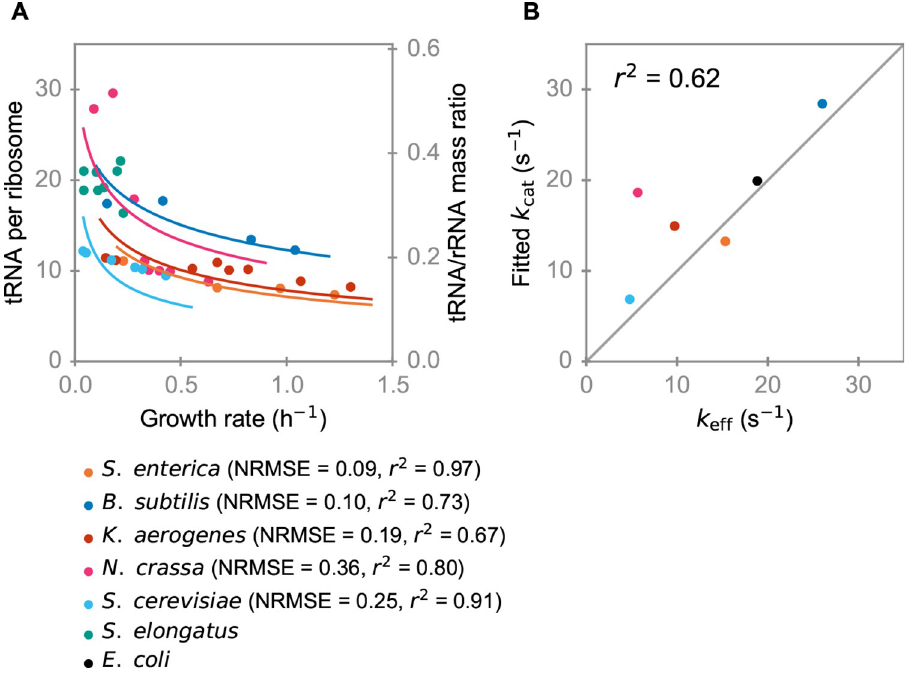
Fig 2. The RNA growth law across species. (A) Experimentally observed tRNA/ribosome expression ratios in different microbes decrease with growth rate, consistent with the predicted optimal tRNA/ribosome expression ratio. For each species except S . elongatus , which is a slow-growing species and shows no systematic growth rate dependence, we fitted Eq (1) to the data by varying the single adjustable parameter k cat (solid lines; the numbers in parentheses after the species names quantify the agreement between the fitted lines and the data). Note that the y-axis on the right-hand side is based on the tRNA/rRNA mass ratio for bacteria. For eukaryotic microbes, the tRNA/rRNA mass ratio should be scaled by a factor of 0.84 according to Eq (15). (B) Comparison of fitted k cat and effective ribosome turnover number k eff